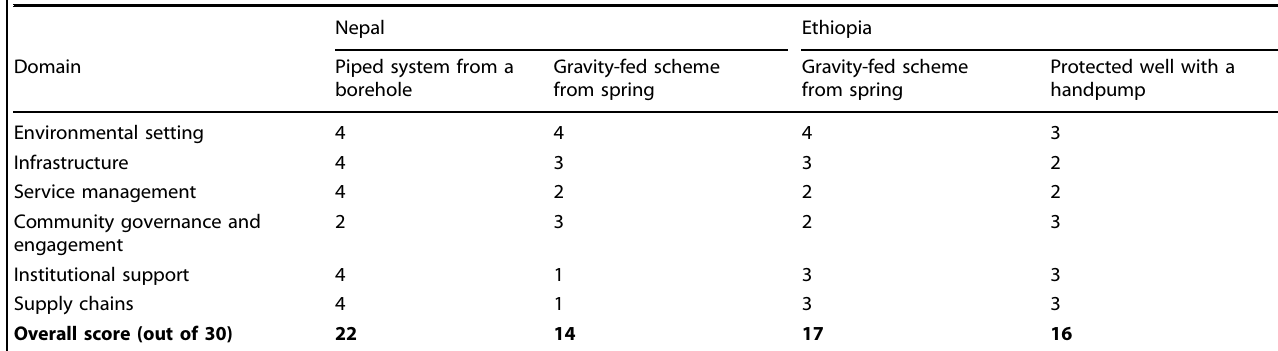
Table 5. Example scoring for four water